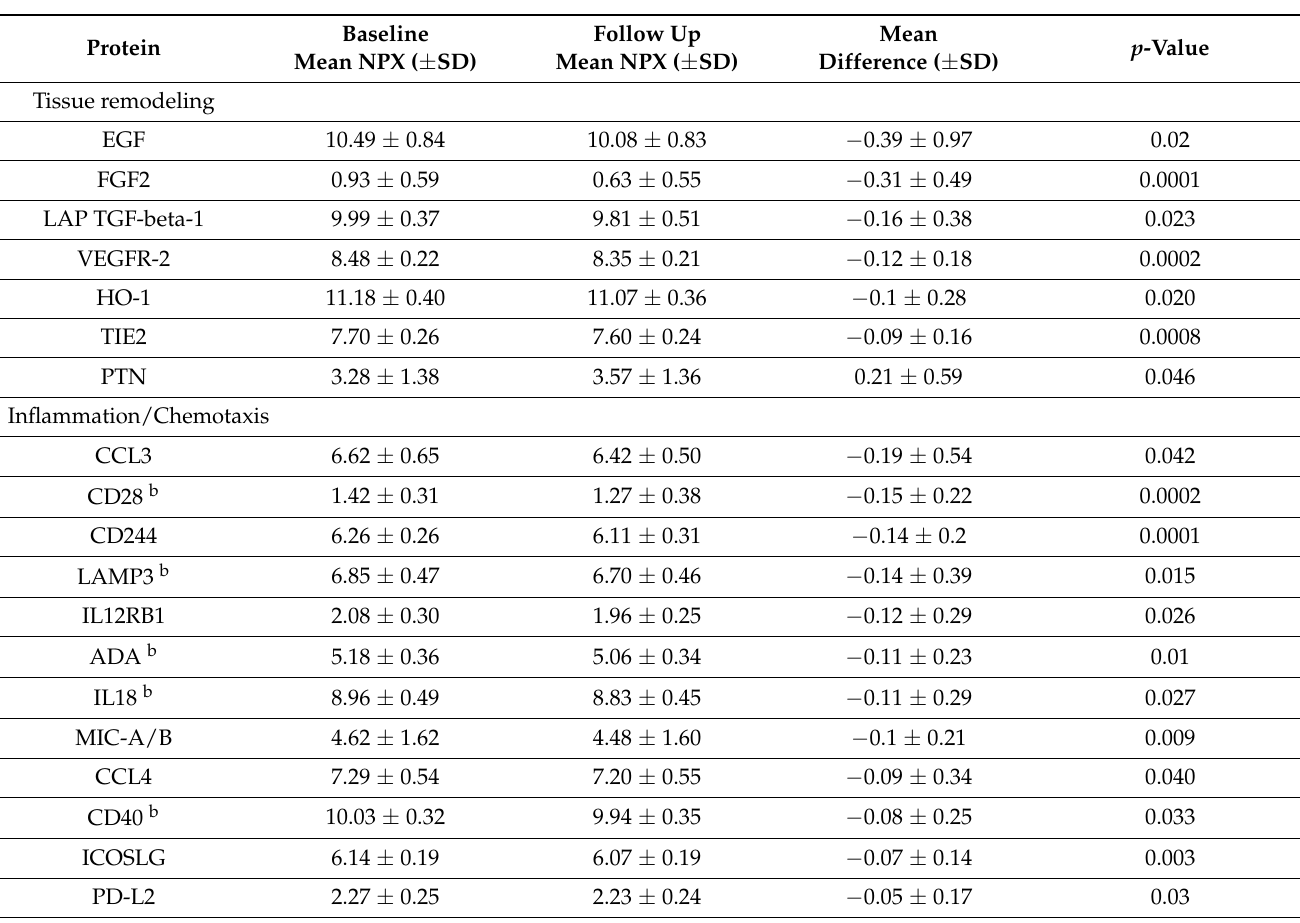
Table 4. Temporal protein changes between IPF baseline and follow up. Protein levels (mean normalized protein expression, NPX) measured in serum from IPF patients that were changed between baseline and follow up. Proteins are categorized in two main biological functions, tissue remodeling and inflammation/chemotaxis. Three proteins have overlapping functions. Proteins significantly elevated in IPF compared to controls are indicated with b . p -values calculated using Wilcoxon signed-rank